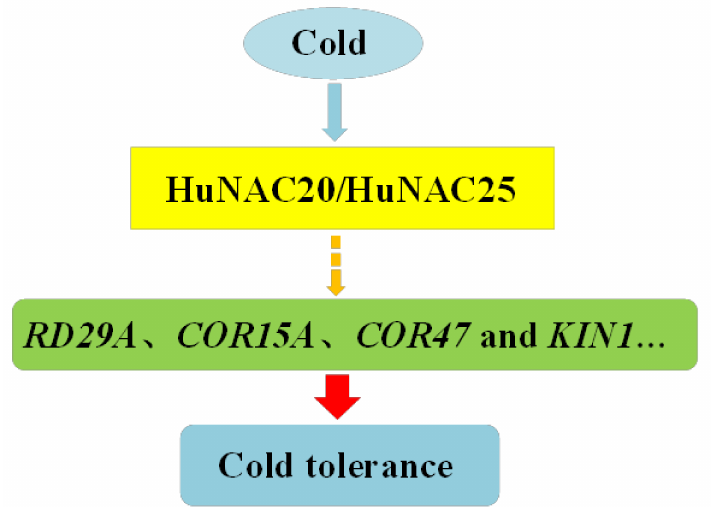
Figure 12. The proposed model of HuNAC20 and HuNAC25-mediated cold stress-responsive signaling. Cold stress induces the expression of HuNAC20 and HuNAC25. HuNAC20 and HuNAC25 regulate the expressions of cold-responsive genes by binding to the cis -elements of cold-responsive proteins in their promoters, and then modulate plant tolerance to cold